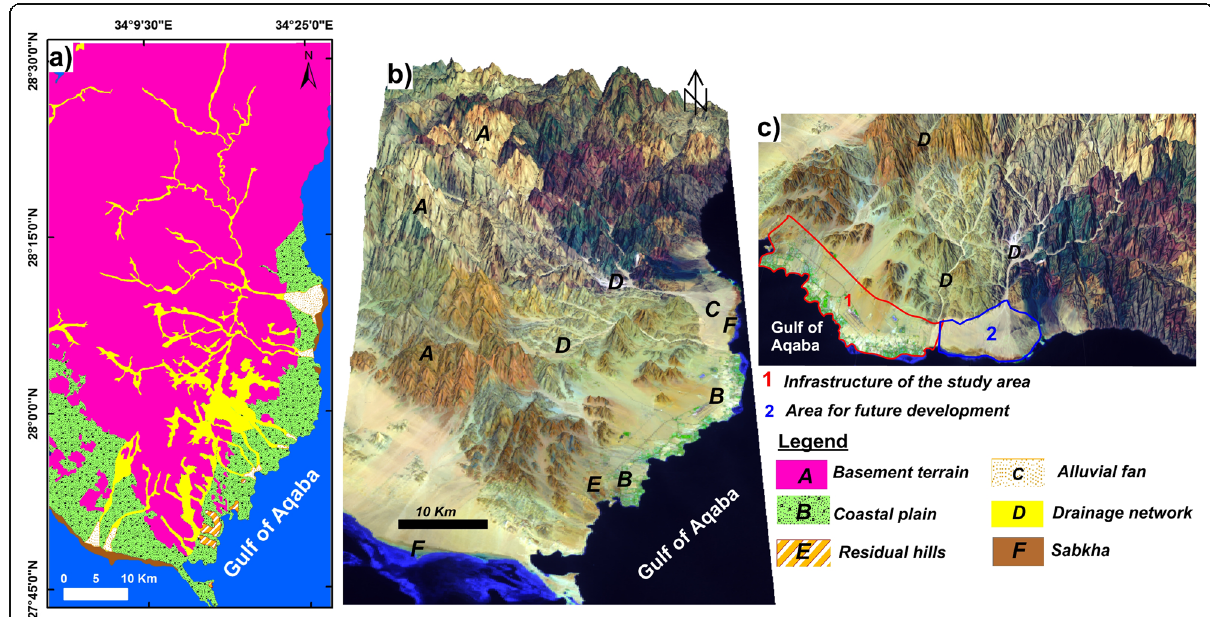
Fig. 3 Discrimination of different landforms of the study area. a Geomorphologic map showing the main geomorphologic unit extracted from topographic (1,25000) map and SRTM DEM data. b Three dimensional map of the study area created by using Landsat 8 image (OLI) where the base height obtained from SRTM DEM. c Side view illustrates the current infrastructure and the expected area for future